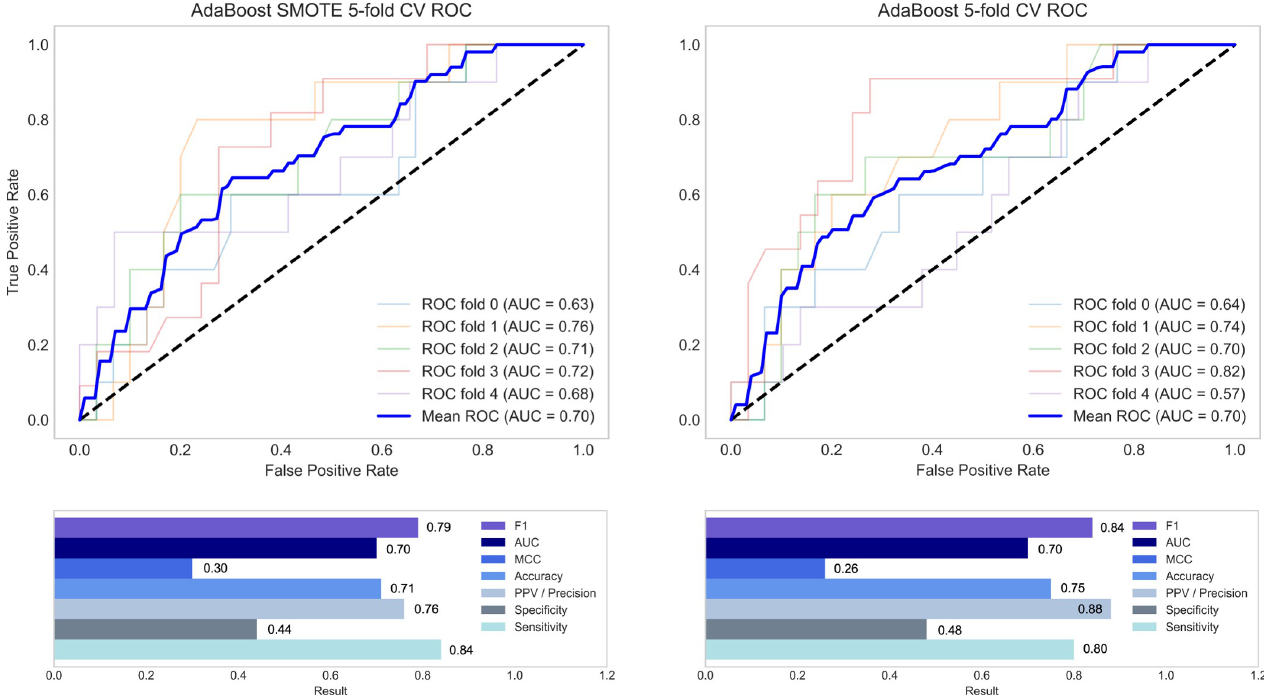
Fig 2. Mean 5-fold cross-validation ROC curves and performance metrics for the top performing classifiers used to predict top quartile change in postoperative ASBS score at 12 months.